Question: Identify the chart type used in this figure.
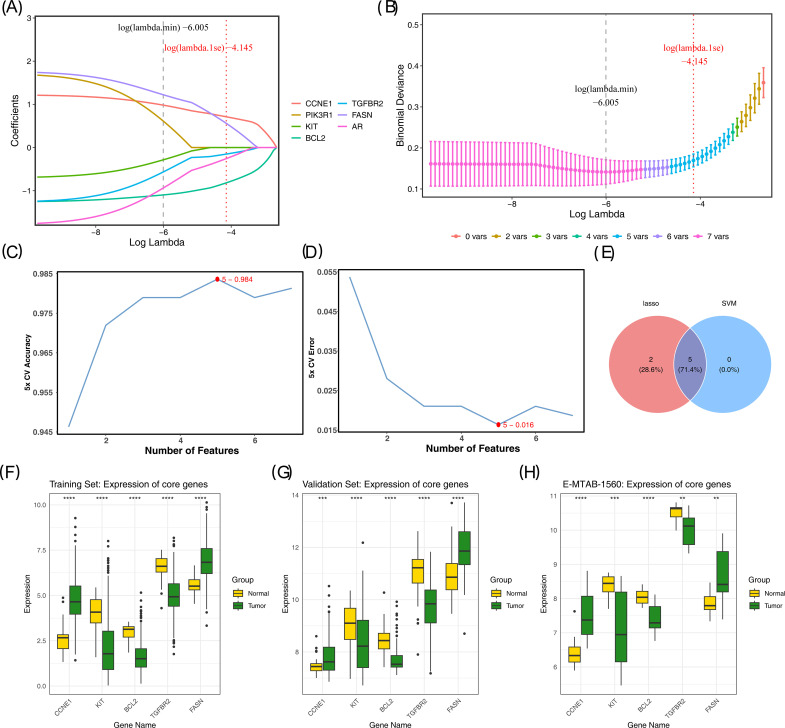
Answer: line